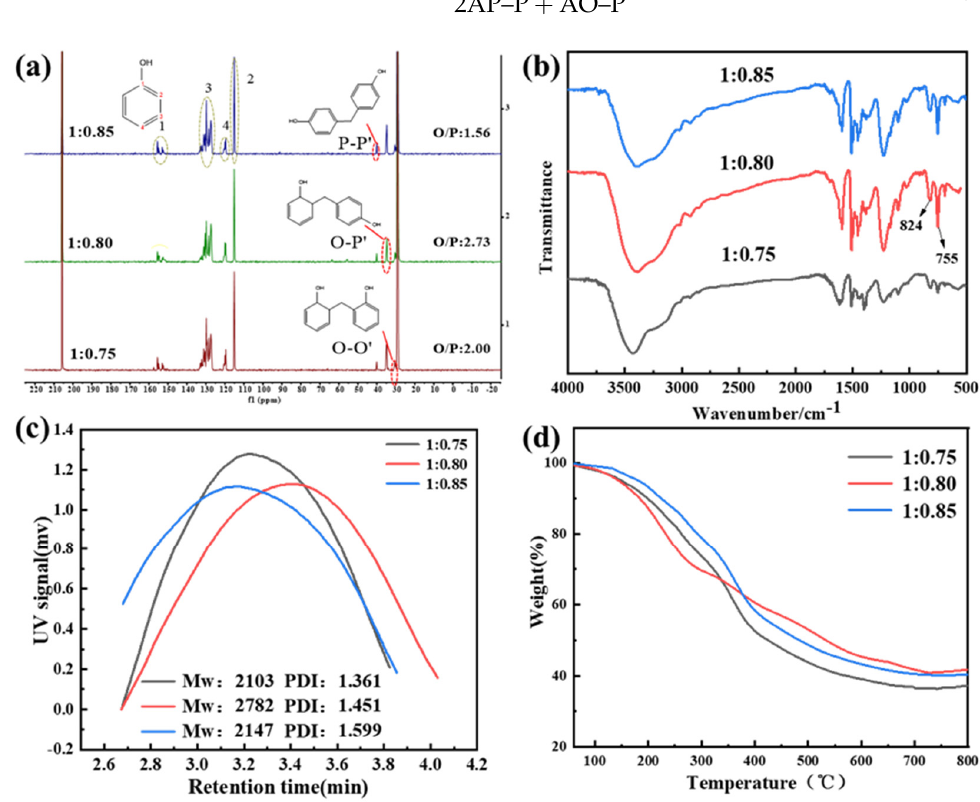
Figure 2. Performance analyses of the LPRs. ( a ) 13 C-NMR pro fi les with di ff erent phenolic ratios, ( b ) FTIR pro fi les with di ff erent phenolic ratios, ( c ) GPC pro fi les with di ff erent phenolic ratios, and ( d ) TGA pro fi les with di ff erent phenolic ratios.